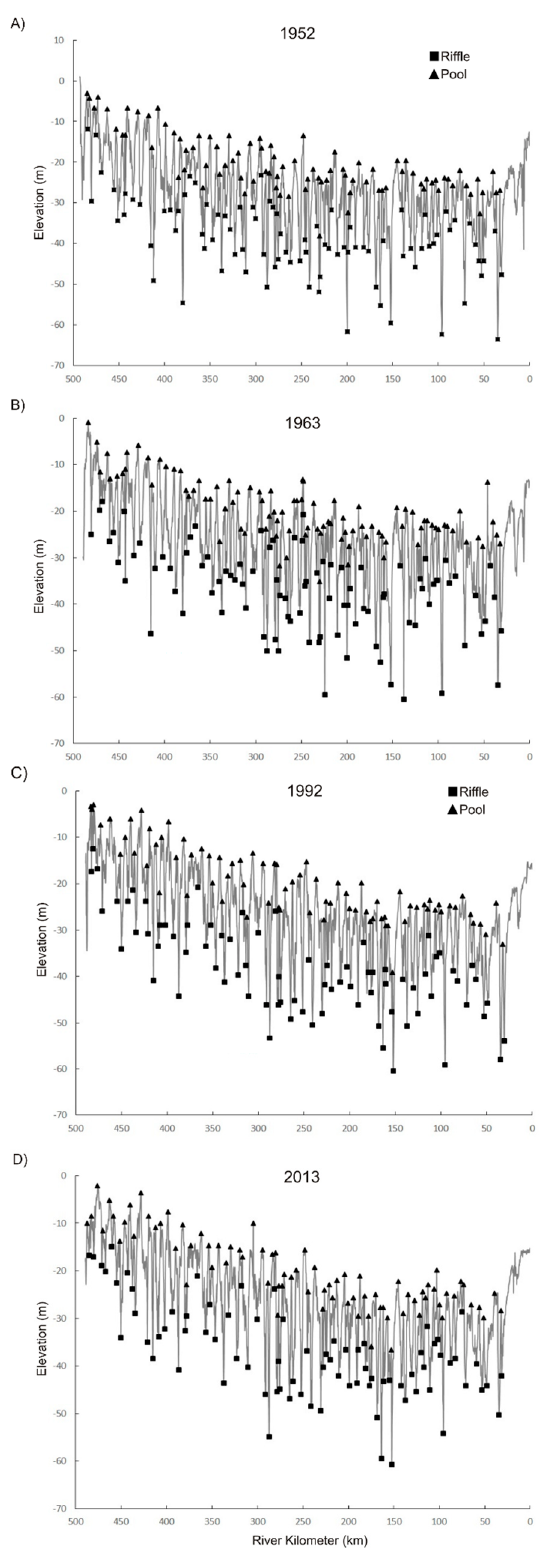
Figure 5. The long thalweg profiles with identified pools and riffles for four hydrographic surveys in 1952 ( A ), 1963 ( B ), 1992 ( C ), and 2013 ( D ). Each thalweg profile is referenced to a standard channel distance from RK 490 to HOP at RK 0. The elevation values are above the North American Vertical Datum of 1988 (NAVD 88).